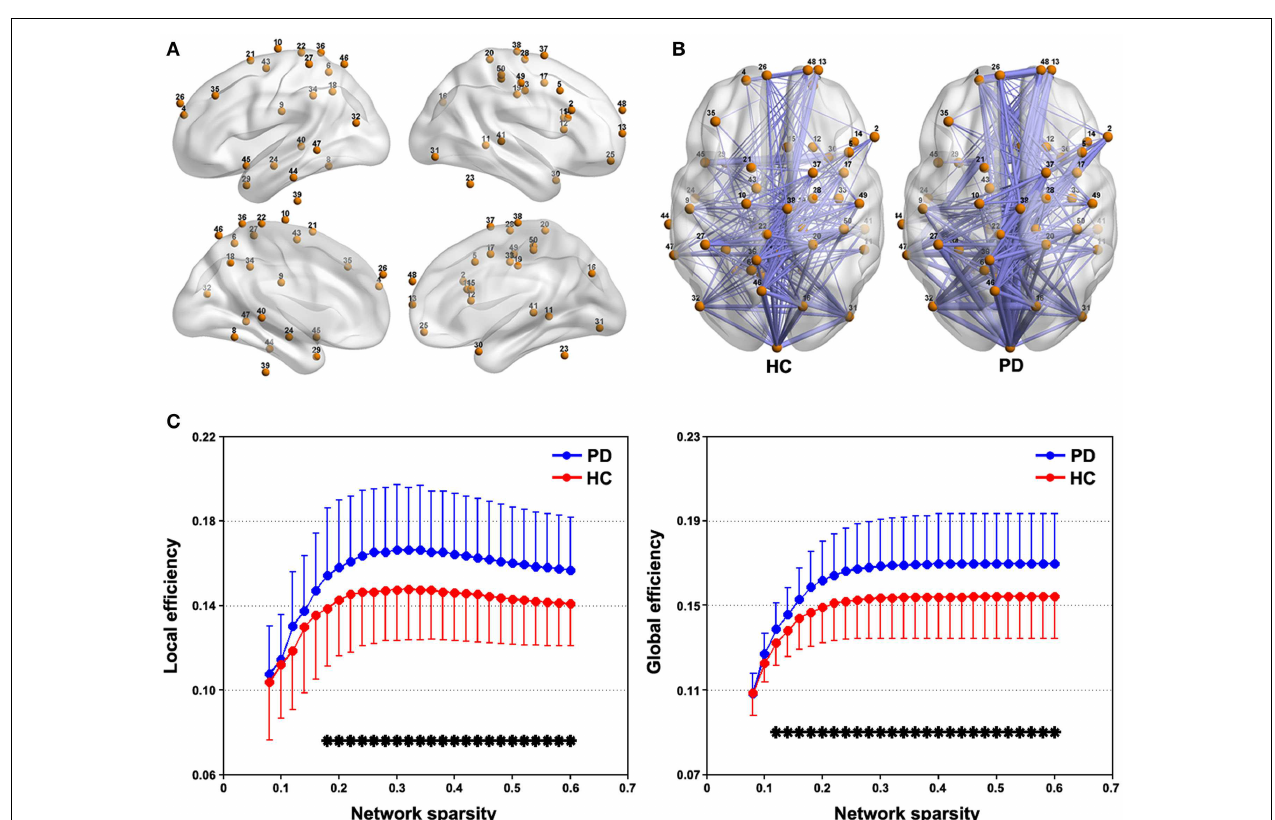
that were thresholded at a sparsity = 0.3. (C) Local and global efficiency the 50-ROI network in the PD and HC groups as a function of sparsity. * P < 0.05, FDR corrected.